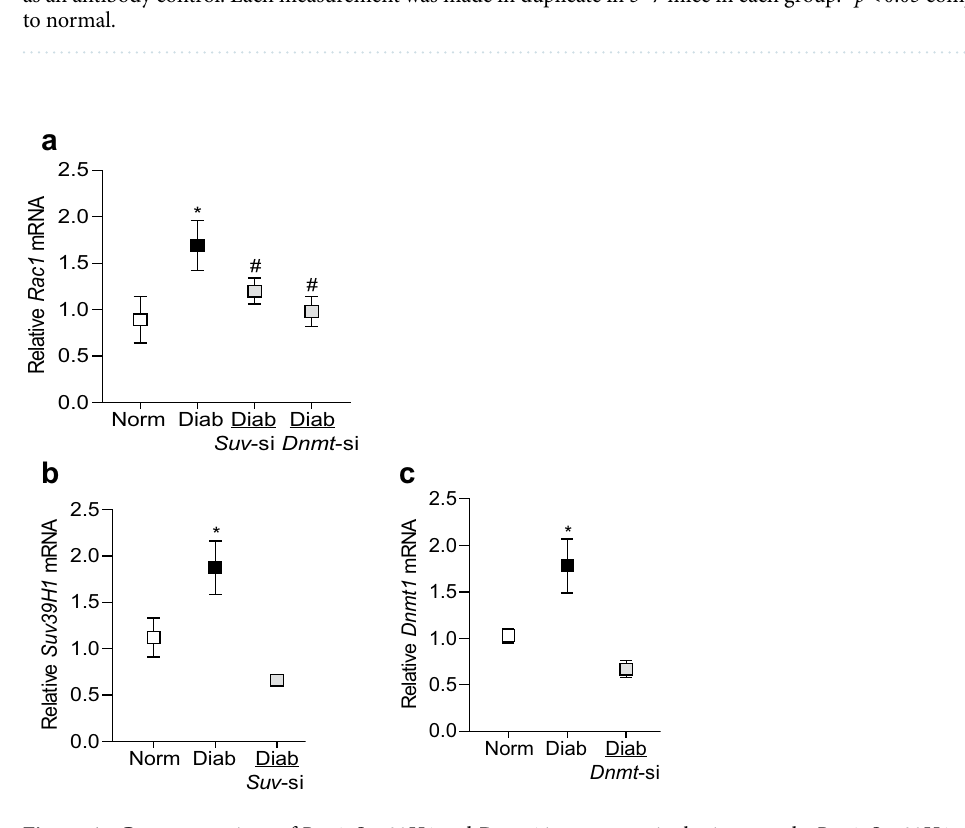
Figure 6. Gene expressions of Rac1, Suv39H1 and Dnmt1 in mouse retinal microvessels. Rac1, Suv39H1 and Dnmt1 gene transcripts were quantified by qRT-PCR using 18S as a housekeeping gene. The values are represented as mean ± SD of 5–6 mice/group, with each measurement made in duplicate. Norm and Diab = Normal and Diabetic mice; Diab/ Suv -si and Diab/ Dnmt1 -si = Mice receiving Suv39H1 -siRNA or Dnmt1 - siRNA, soon after induction of diabetes. * p < 0.05 compared to normal and # p < 0.05 compared to